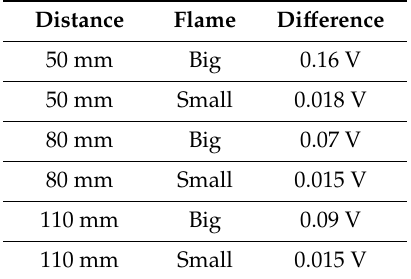
Table 2. Amplitudes differences of the recorded signals.